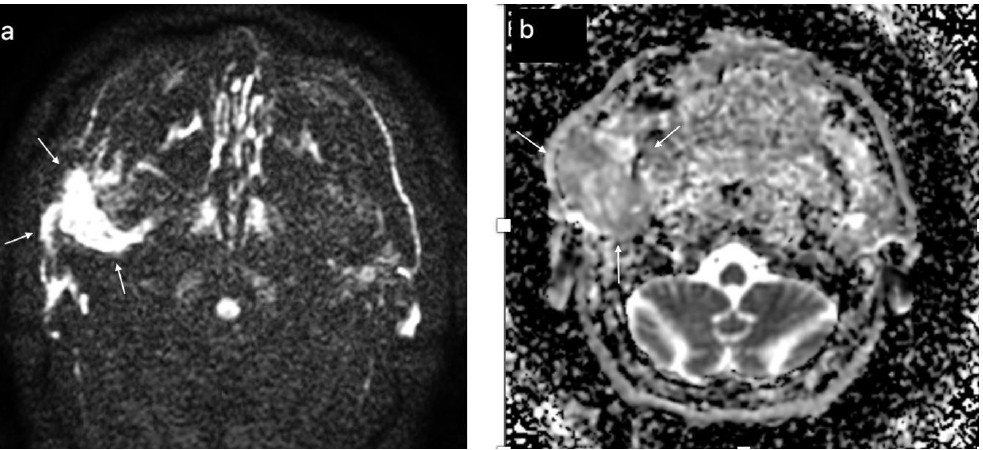
Figure 8. Malignant tumor of the left parotid gland (white arrows); DWI sequences ( a ) with ADC map ( b ) showing a value of 1.1 × 10 − 3 mm 2 /s.